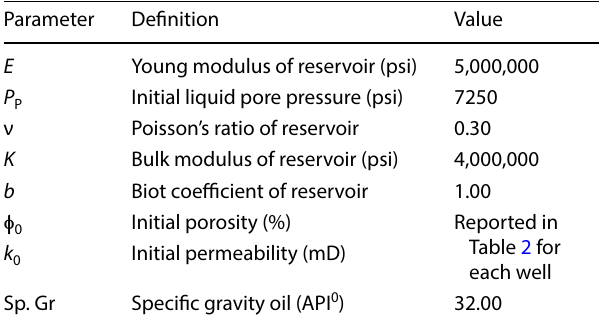
Table 1 Poromechanical parameters for the case carbonate field studied Parameter